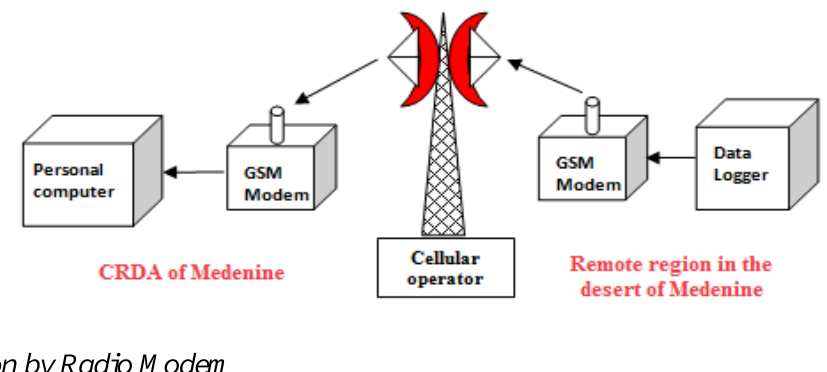
Figure 4. Scheme of field data transmission through the GSM Modem/GPRS.